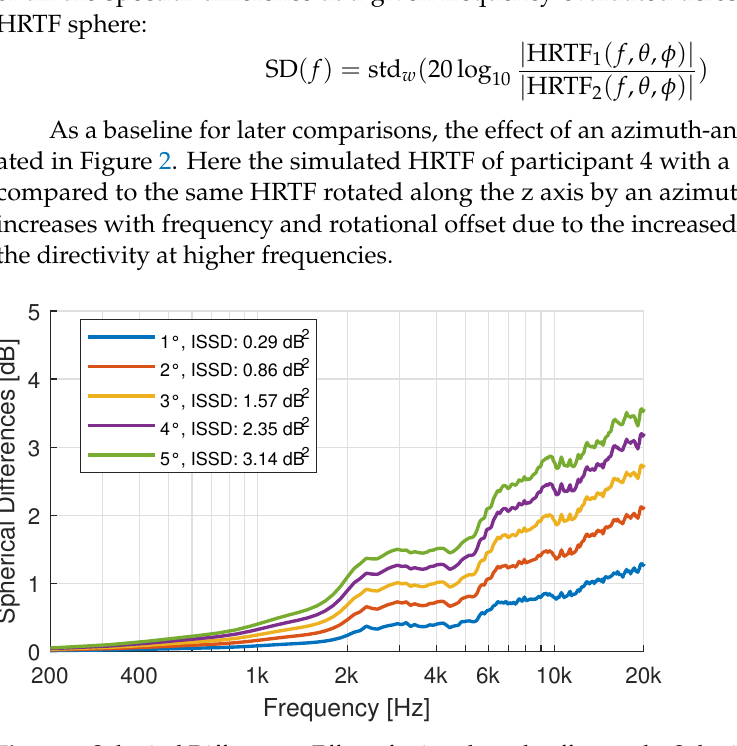
Figure 2. Spherical Differences: Effect of azimuth angle offset on the Spherical Differences and ISSD difference metrics of a 1 × 1-degree HRTF measurement of the